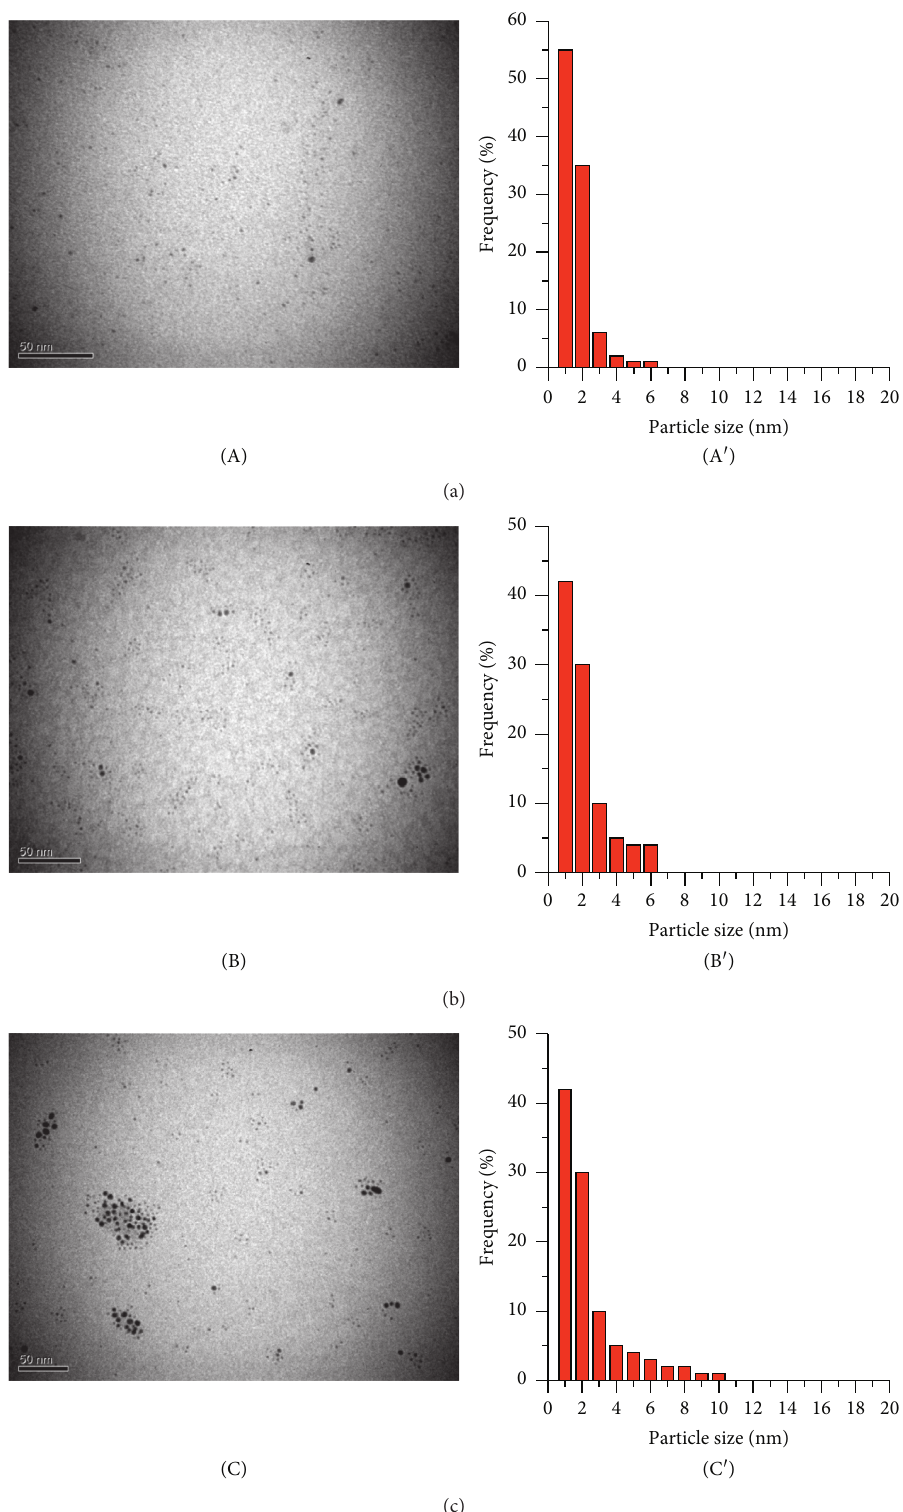
Figure 6: TEM images (A, B, C) and the size distribution histograms (A ′ , B ′ , C ′ ) of AgNPs, synthesized in RL solution (2g/L) at t � 20 (a), 40 (b), and 60 ° C